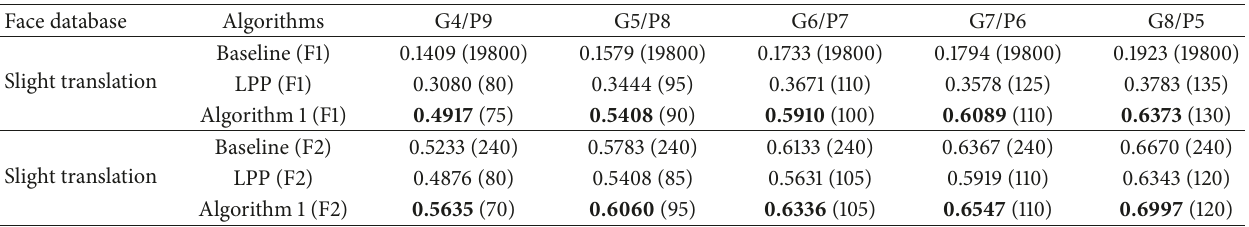
Table 8: The recognition rates on slight translation AR face database over “F1” and “F2” features; recognition rates (dimensionality). Face database